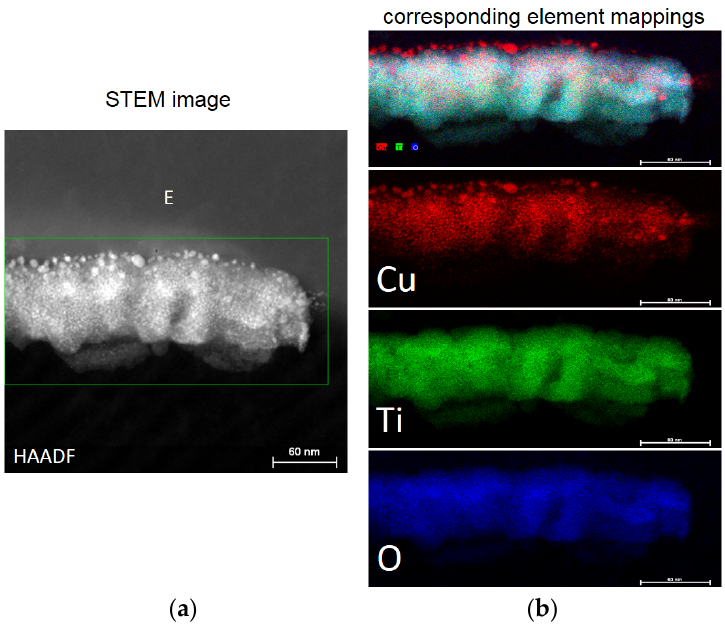
Figure 10. High ‐ Angle Annular Dark ‐ Field imaging (HAADF) images of Cu ‐ TiO 2 HIPIMS sputtered Figure 10. ( a ) High-Angle Annular Dark-Field imaging (HAADF) images of Cu-TiO 2 HIPIMS sputtered for 150 s showing the complete sample and the mapping of Cu, Ti, and O by Z ‐ contrast imaging. for 150 s showing the complete sample and ( b ) the mapping of Cu, Ti, and O by Z-contrast 2.8. Interfacial Charge Transfer (IFCT) Suggested on TiO 2 ‐ Cu Films Leading to Gram ‐ Negative and